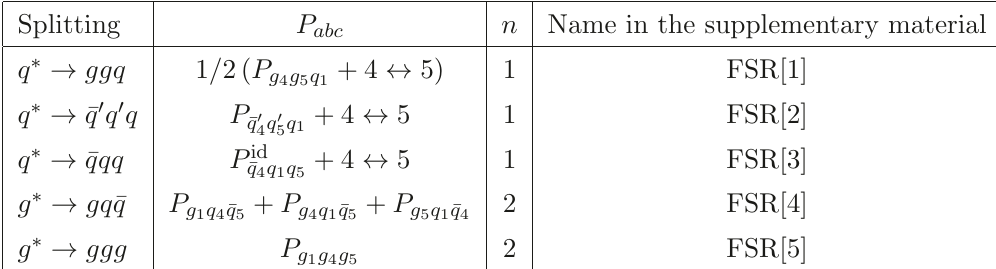
Table 2 . Overview of integrated triple-collinear subtraction terms for final state splittings. In